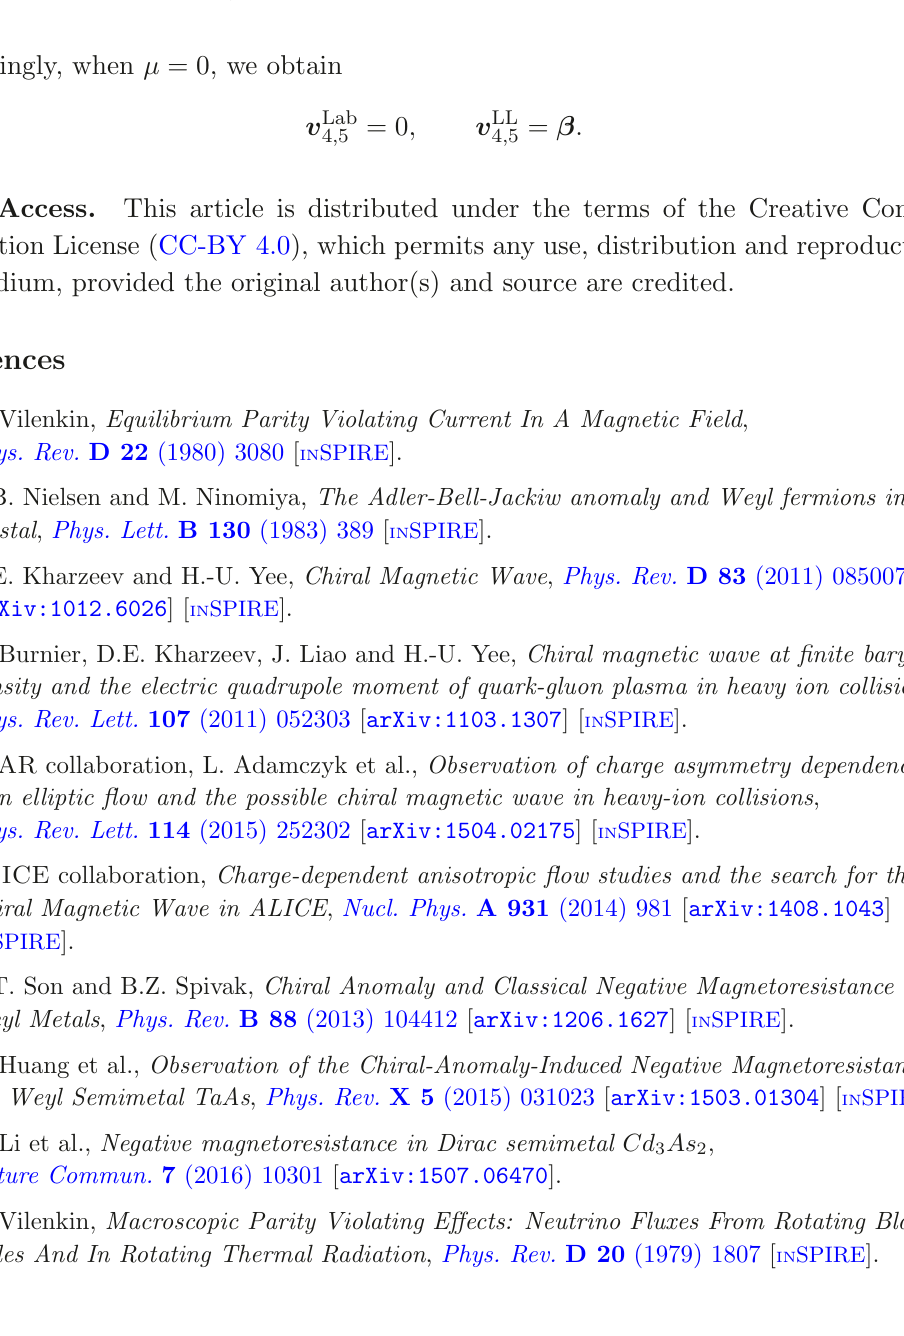
Table 3 . Hydro modes in Lab frame versus those in LL